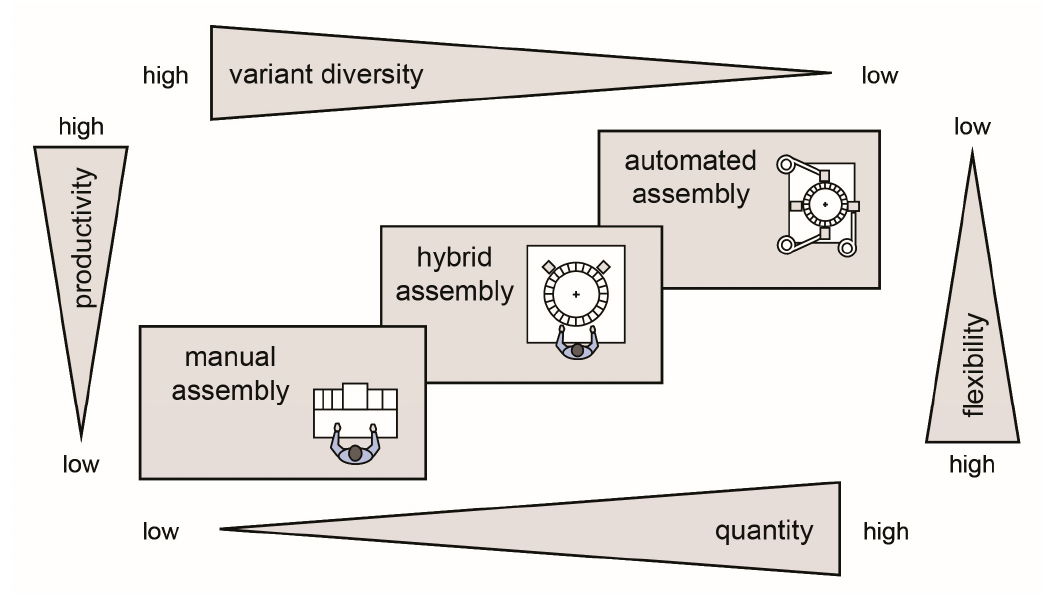
Figure 1. Utilization areas for manual, hybrid and automated assembly concepts. Reprinted by permission from Springer: Changeable and Reconfigurable Assembly Systems by B. Lotter and H.-P. Wiendahl (COPYRIGHT 2009).